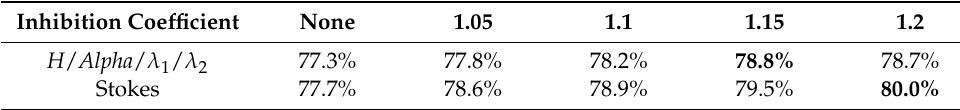
Figure 10. Image stretching result with different expansion coefficients: ( a ) original pseudo-color image, ( b ) SLIC superpixel, ( c ) SLIC superpixel with 1.2 expansion coefficient, ( d ) SLIC superpixel with 1.4 expansion coefficient, ( e ) SLIC superpixel with 1.6 expansion coefficient, and ( f ) SLIC superpixel with 1.8 expansion coefficient. Table 8. MIoU value of different inhibition